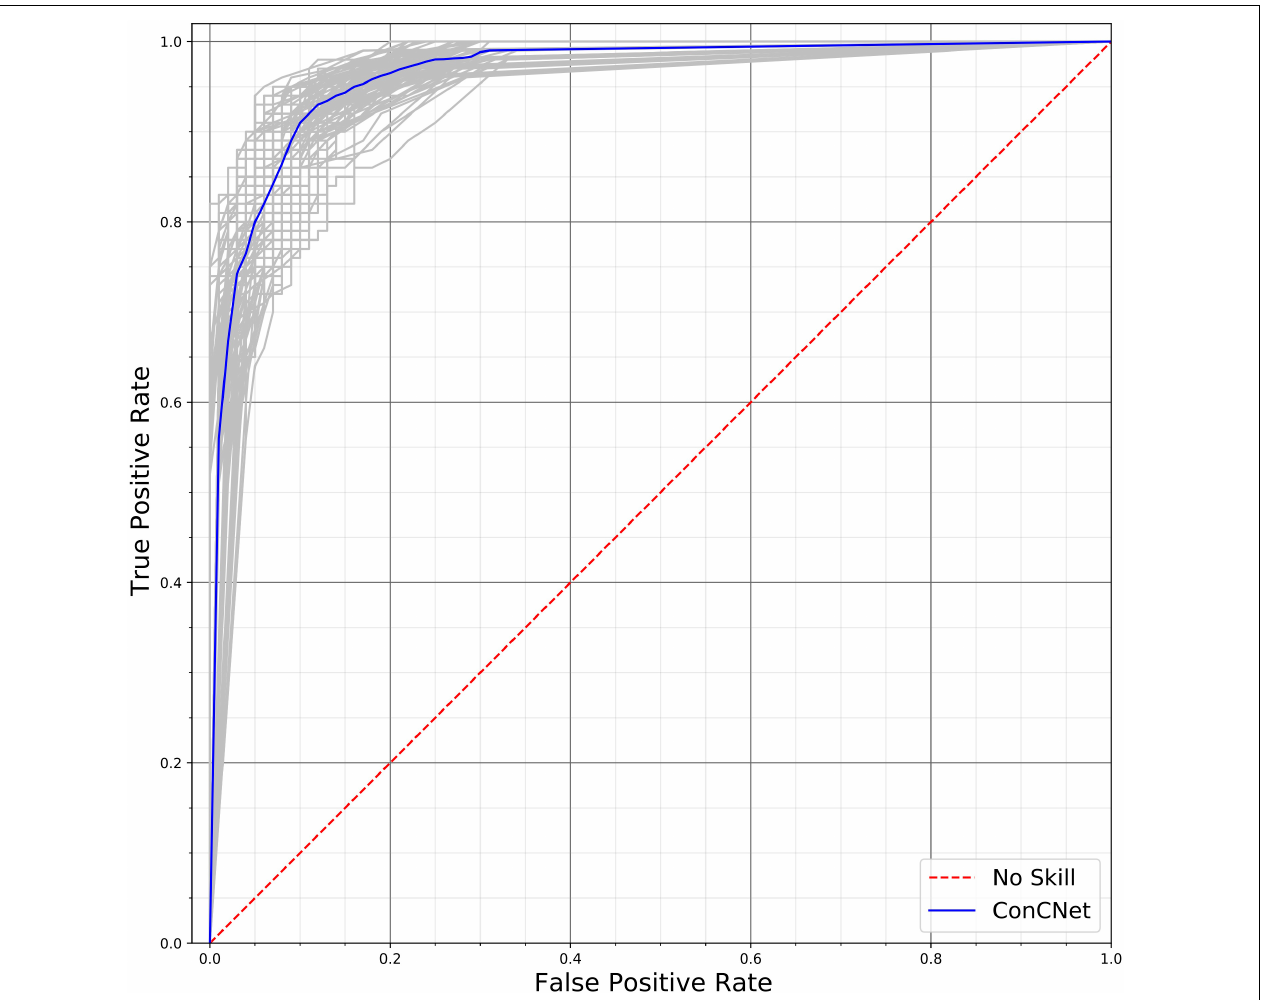
FIGURE 11 | Receiver operating characteristic (ROC) curves for the 100 ConcNet 2 networks used in MCCV. The gray curves show the results for each of the 100 networks and the blue curve shows the median. The ensemble median Area Under the Curve (AUC) is 0.961 (the 25% and the 75% percentile are 0.952 and 0.969,